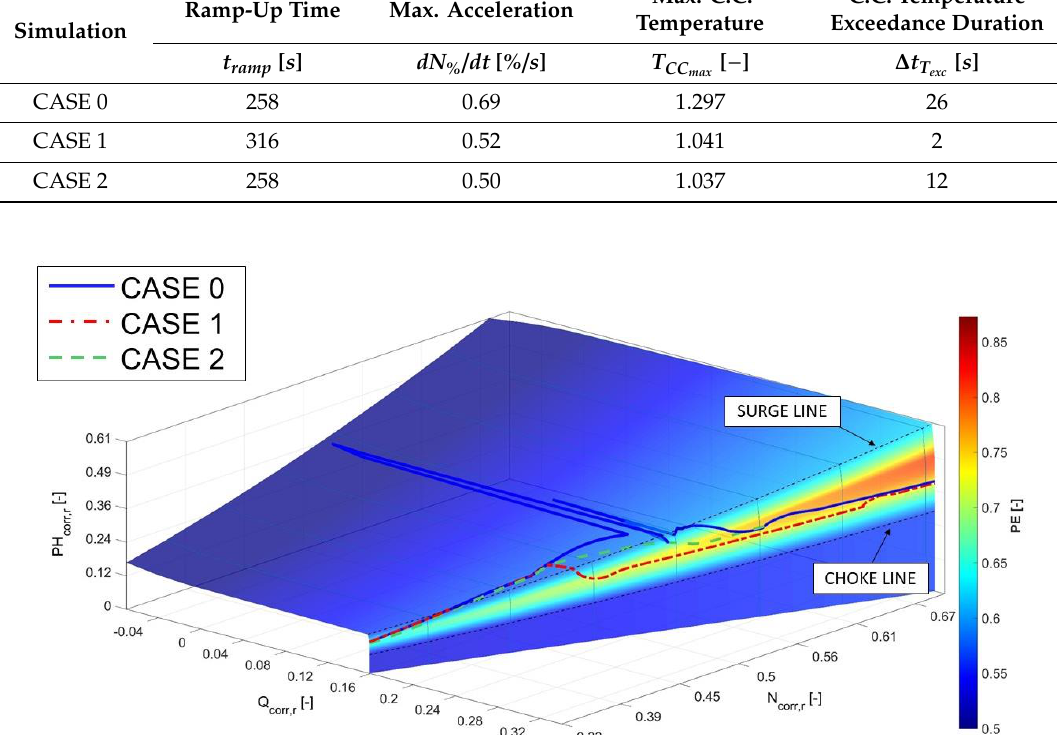
Table 2. Start-up simulations to full-speed no-load (FSNL)—Comparison of features. Ramp-Up Time Simulation